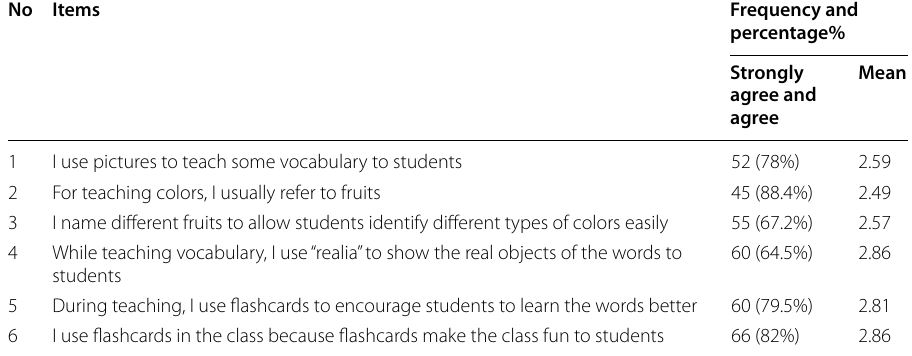
Table 2 Teaching vocabulary through visual aids